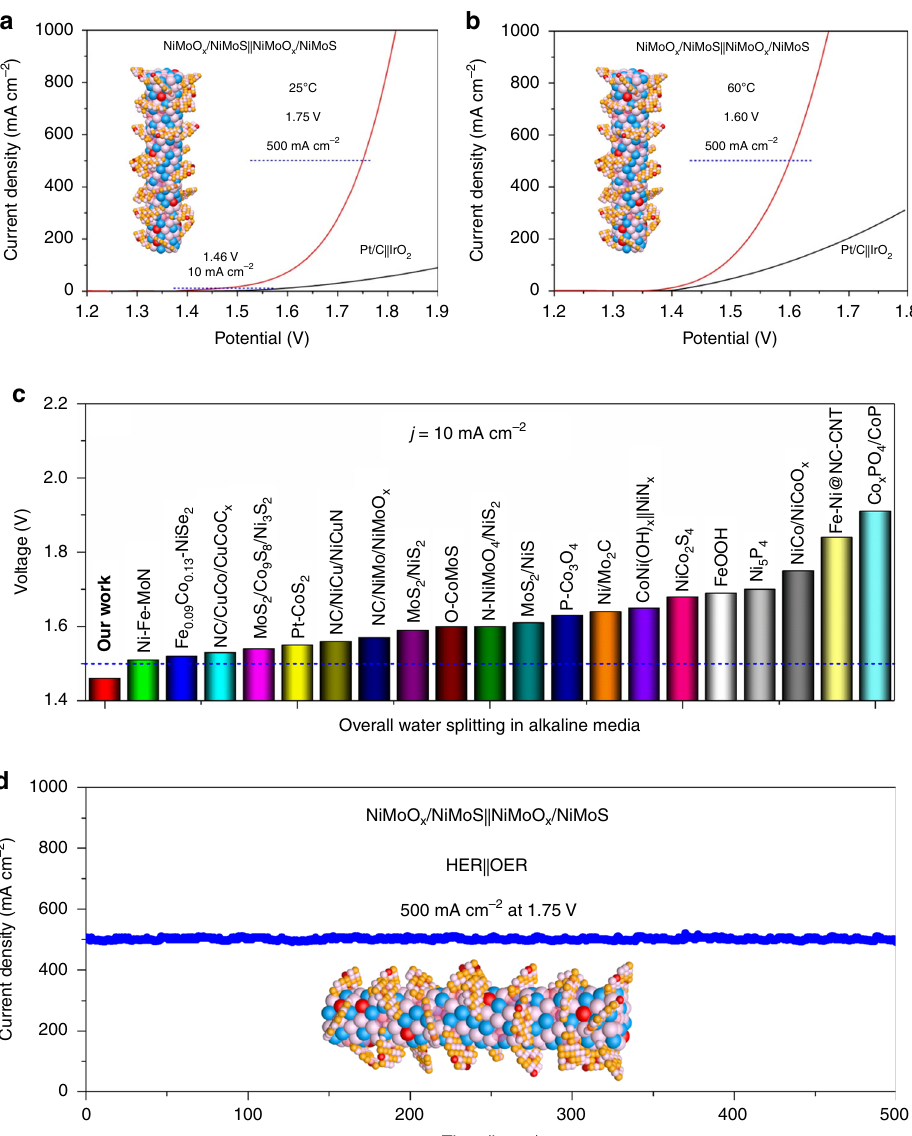
Fig. 7 Electrocatalytic performance for overall water splitting. a , b Polarization curves by two-electrode system in a 1 M KOH at 25°C and b 6 M KOH at 60°C. c Comparison of the cell voltage at 10mAcm − 2 for NiMoO x /NiMoS with previously reported catalysts 8,15,20,25,30,42,47,52 – 64 . d Chronoamperometric test at 1.75V in 1.0M KOH at 25